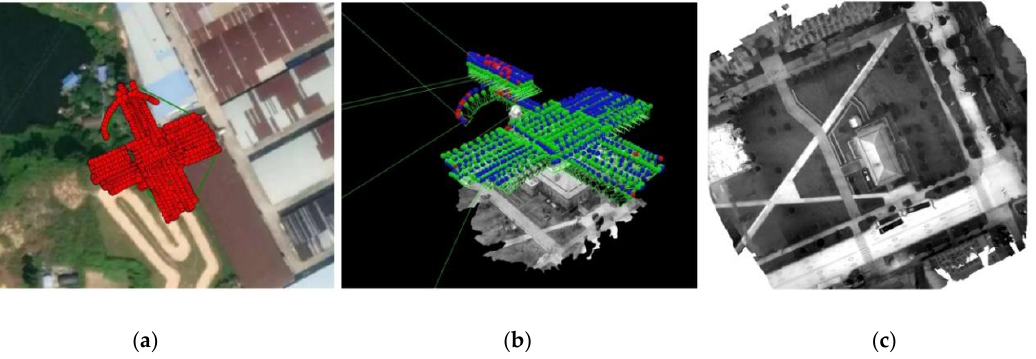
Figure 6. Images of ( a ) the flight plan, ( b ) the digital surface model (DSM), and ( c ) the digital orthophoto map (DOM).